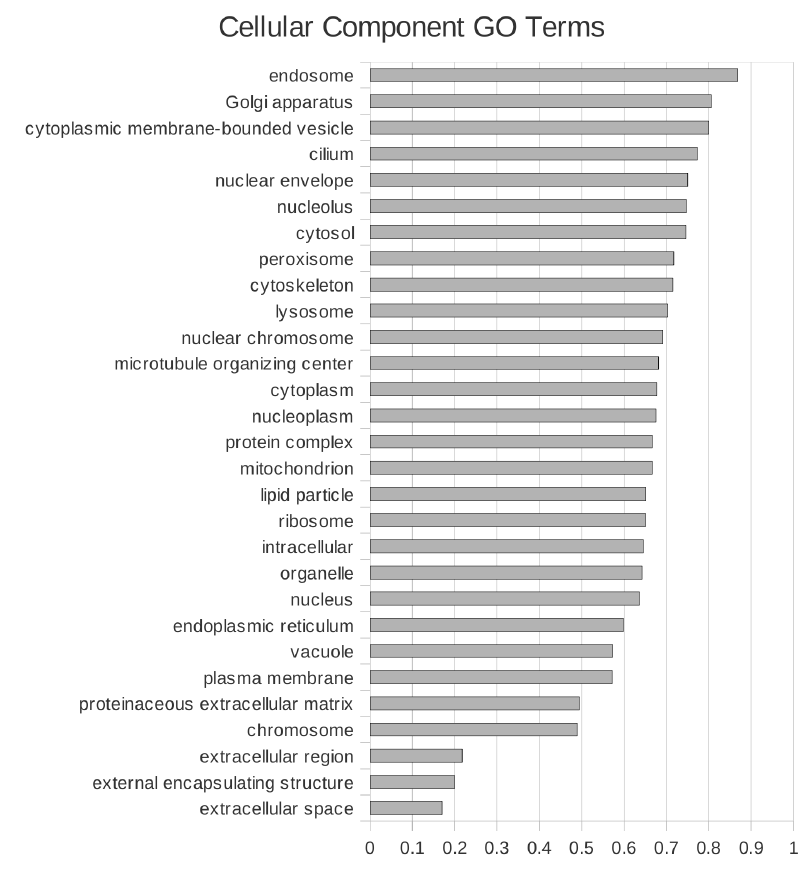
Figure 5. Relative conservation of homology between Elliptiocomplanata and Drosophilamelanogaster transcriptomes, by cellular component ontology term. The proportion of gene ontology terms assigned to D. melanogaster genes that were matched by BLASTX to E. complanata contigs, relative to the total number of D. melanogaster genes in each GO category.